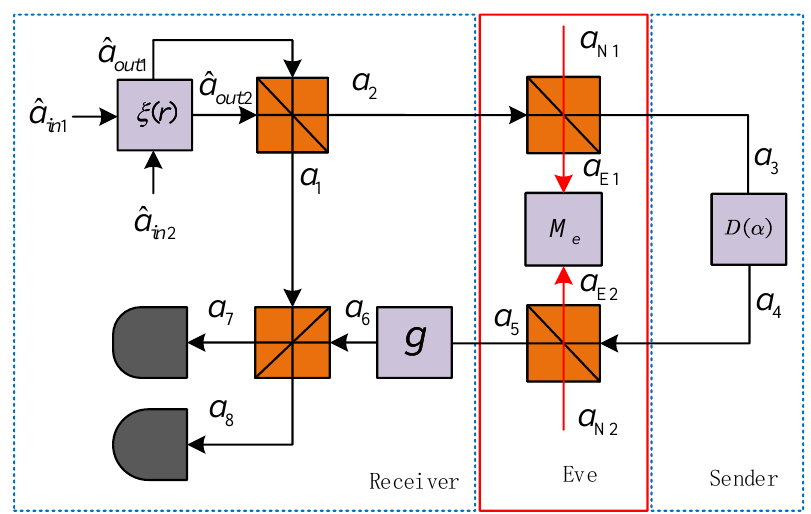
Figure 2. Schematic of distribution based on two-mode squeezed vacuum state.